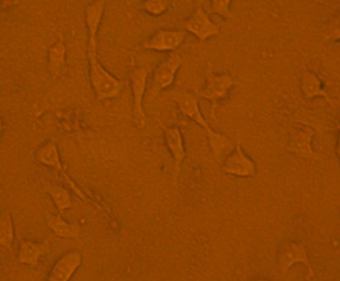
Fig. 3. The cytotoxic effect of the tested E. coli isolate on HEp-2 cells with almost complete detachment 3 h post